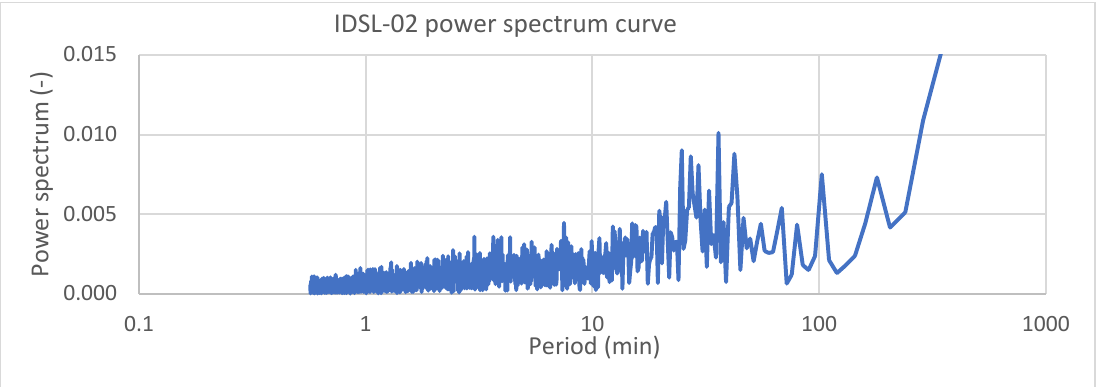
Figure 6 . Power spectrum of the Saidia Marina sea level curve.